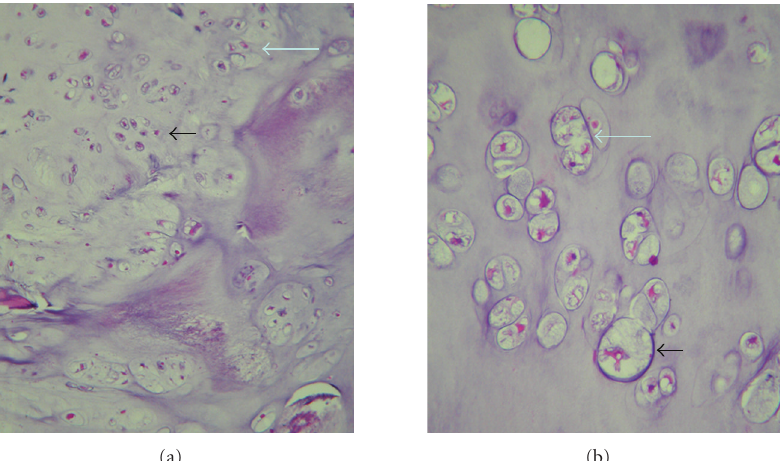
Figure 6: (a) Low-power (10 × ) photomicrograph of the low-grade chondrosarcoma includes cells that are more crowded (small arrow) and disorganized (large arrow) than most osteochondromas. (b) High-power (40 × ) photomicrograph of chondrocytes of a low-grade chondrosarcoma is often enlarged (small arrow), and binucleation is common (large arrow). progression in adults, none are specific symptoms in the growing child [1, 10,